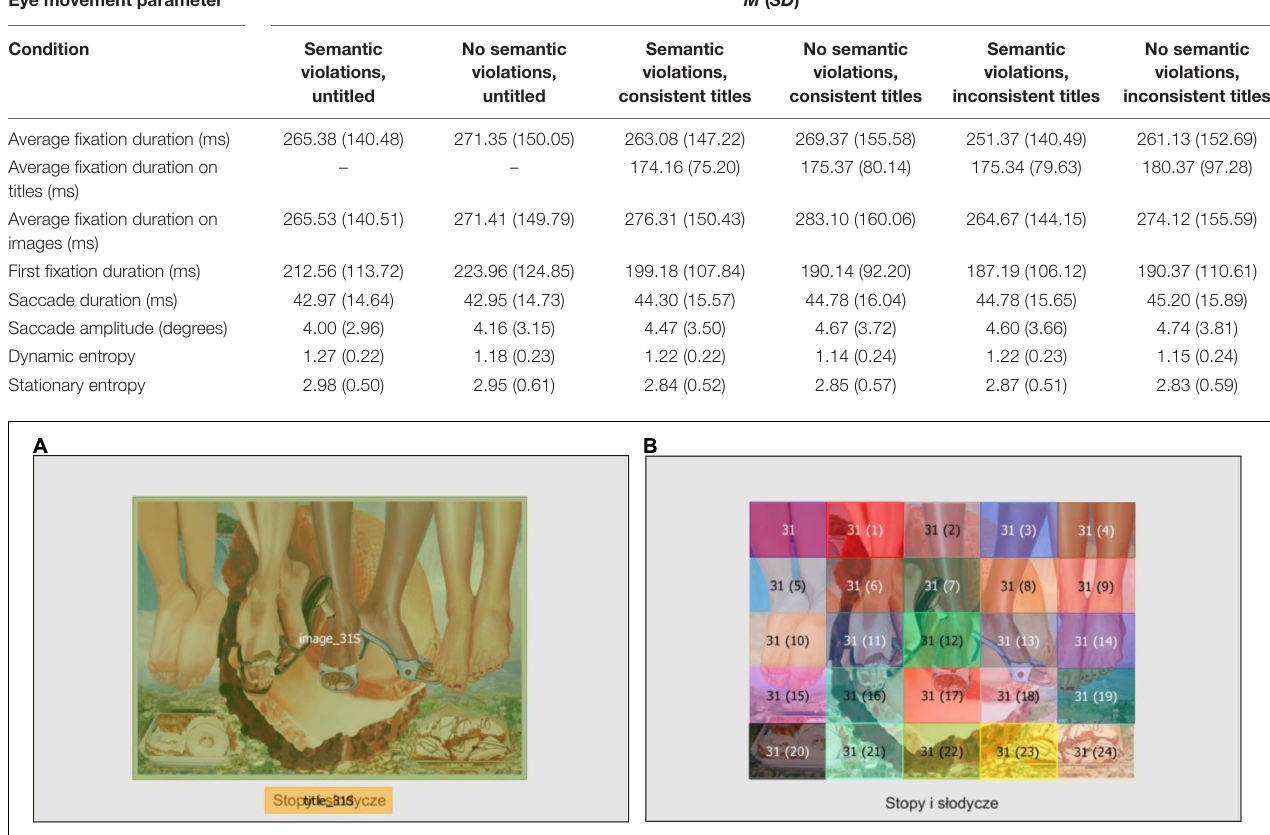
TABLE 2 | Descriptive statistics for the overall eye movement parameters grouped by semantic violations and title condition. Eye movement parameter